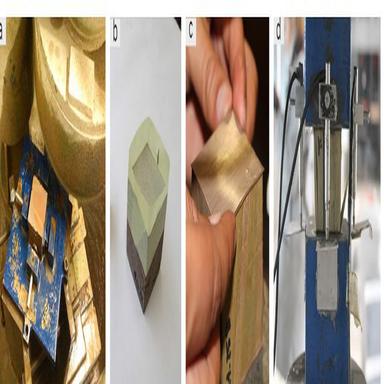
Uniaxial compression tests preparation: (a) and (b) levelling of specimens; (c) applying Teflon sheets with lubrication oil; (d) test setup with three LVDTs and top and bottom loading plates.